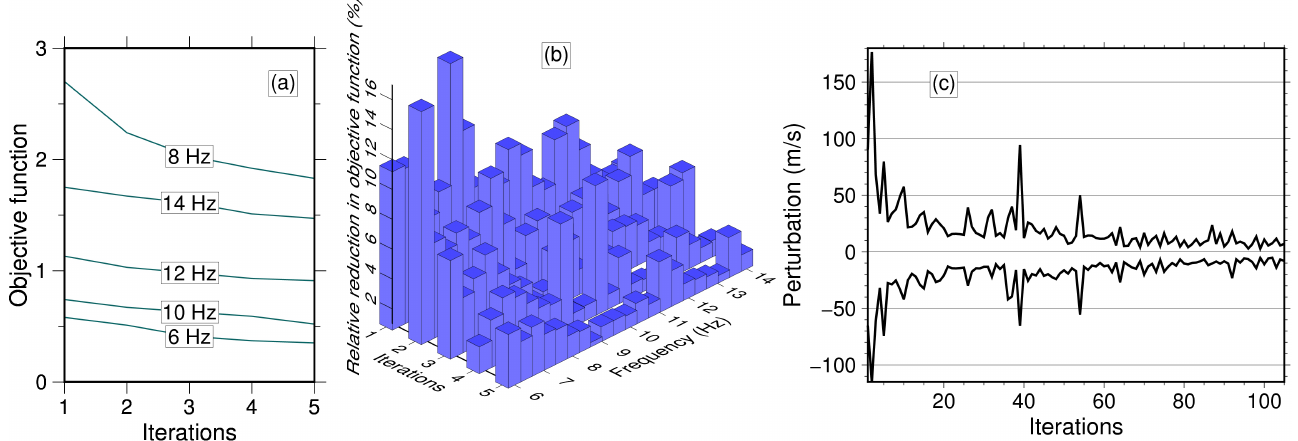
Figure 11. ( a ) Decrease in objective function, ( b ) relative reduction in objective function, and ( c ) final velocity perturbation. A total of 21 frequencies were used in inversion. Sequential iteration number over all frequencies is used in ( c ), in contrast to iteration number at a given frequency used in ( a , b